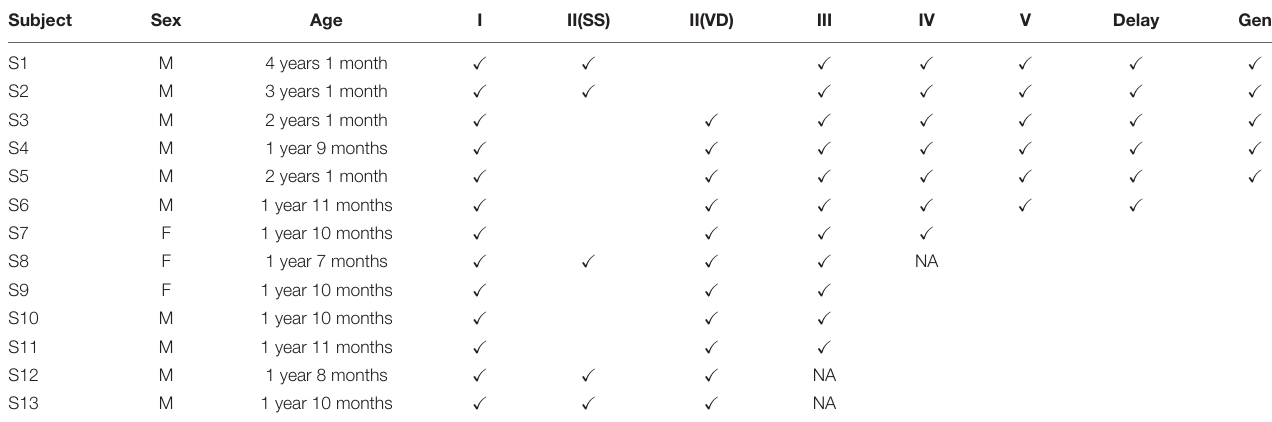
TABLE 1 | Characteristics and training history of subject marmosets used in this study.